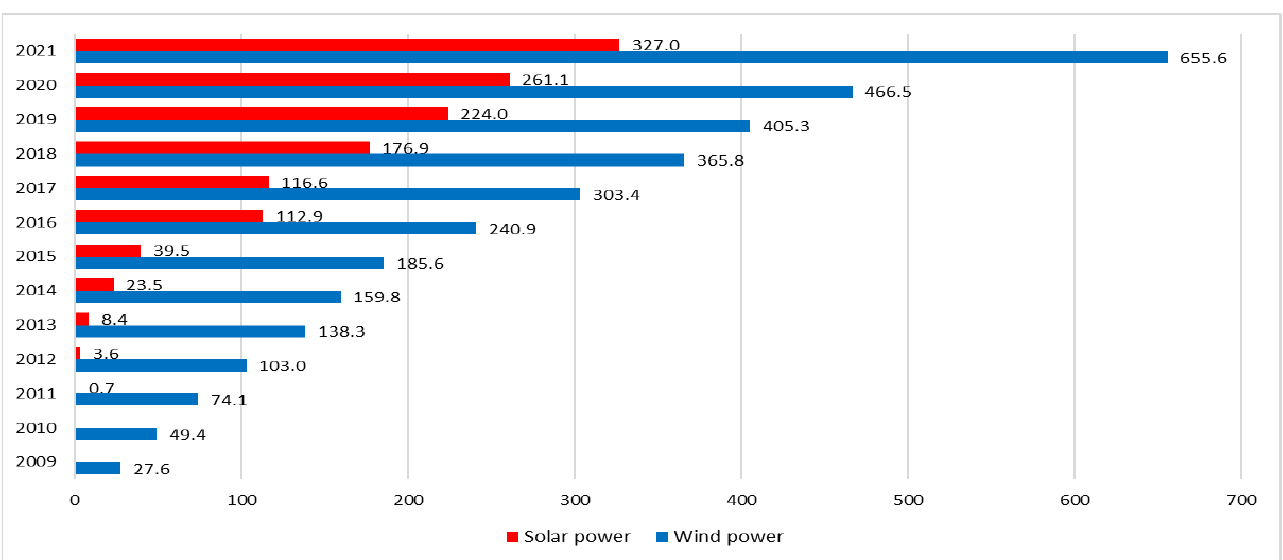
Figure 3. Installed capacity of wind and solar power in China (unit: GW). Notes: The data for solar power in 2009 are not available due to the dataset’s negligible size. Source: National Bureau of Statistics of China, China’s Statistical Yearbooks, various issues, available at http://www.stats.gov. cn/tjsj/ (accessed on 31 December 2022).